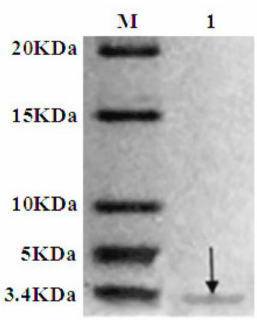
Figure 4. Tricine-SDS-PAGE and antibacterial analysis of purified recombinant C–L. Lane M, the molecular weight of marker; Lane 1, the purified recombinant C–L, arrow in the lane indicated the recombinant C–L.